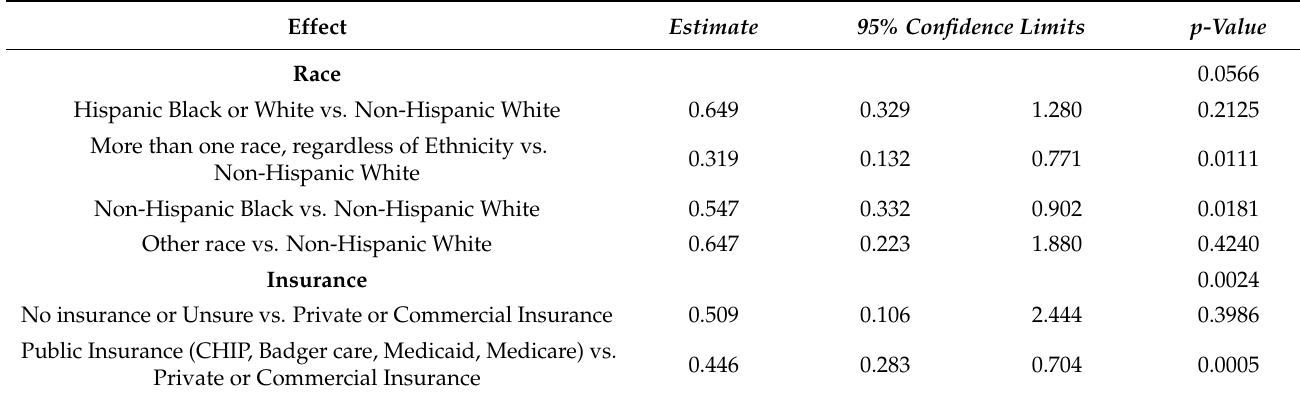
Table A1. Logistic Regression Model for Plans to Vaccinate Child for Influenza.